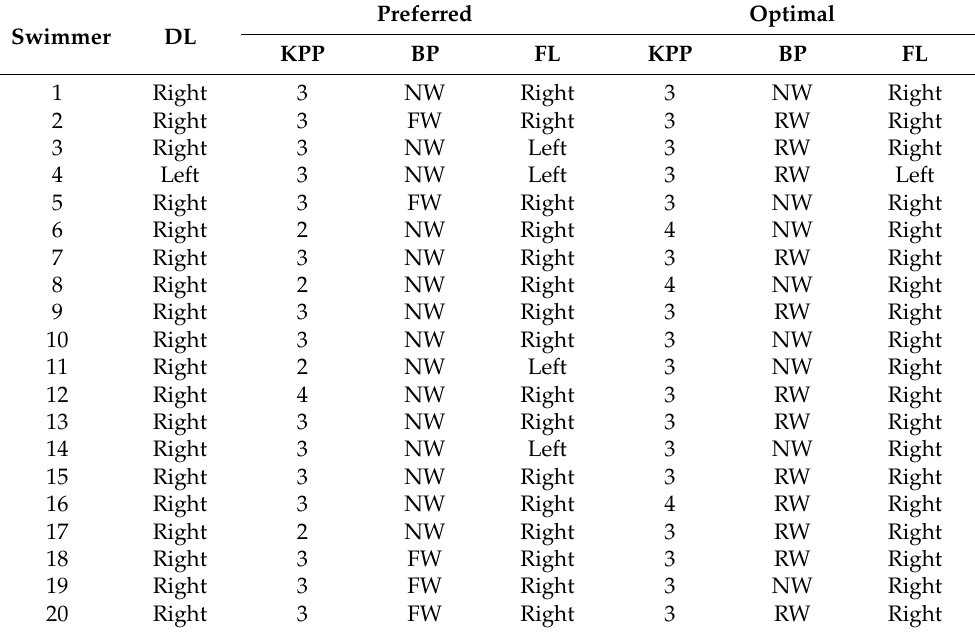
Table 1. Preferred and optimal kick-start positions.